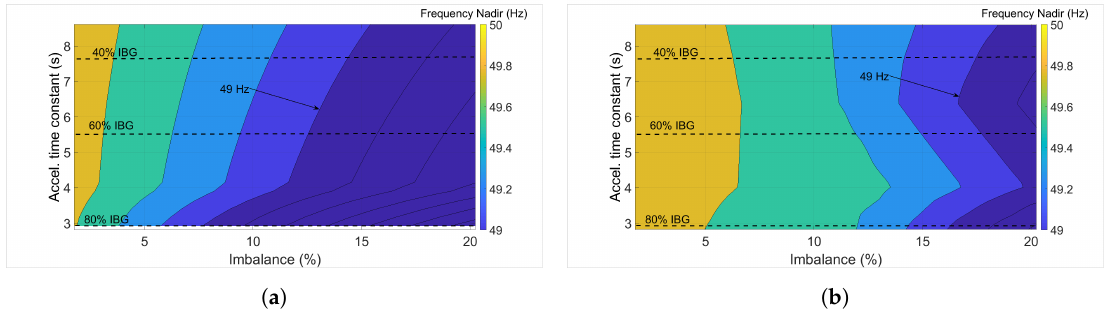
Figure 10. ( a ) Frequency nadir of the simplified IEEE model with only synchronous reserve. ( b ) Frequency nadir of the simplified IEEE model with 40% of the IBG equipped with synthetic inertia controls.